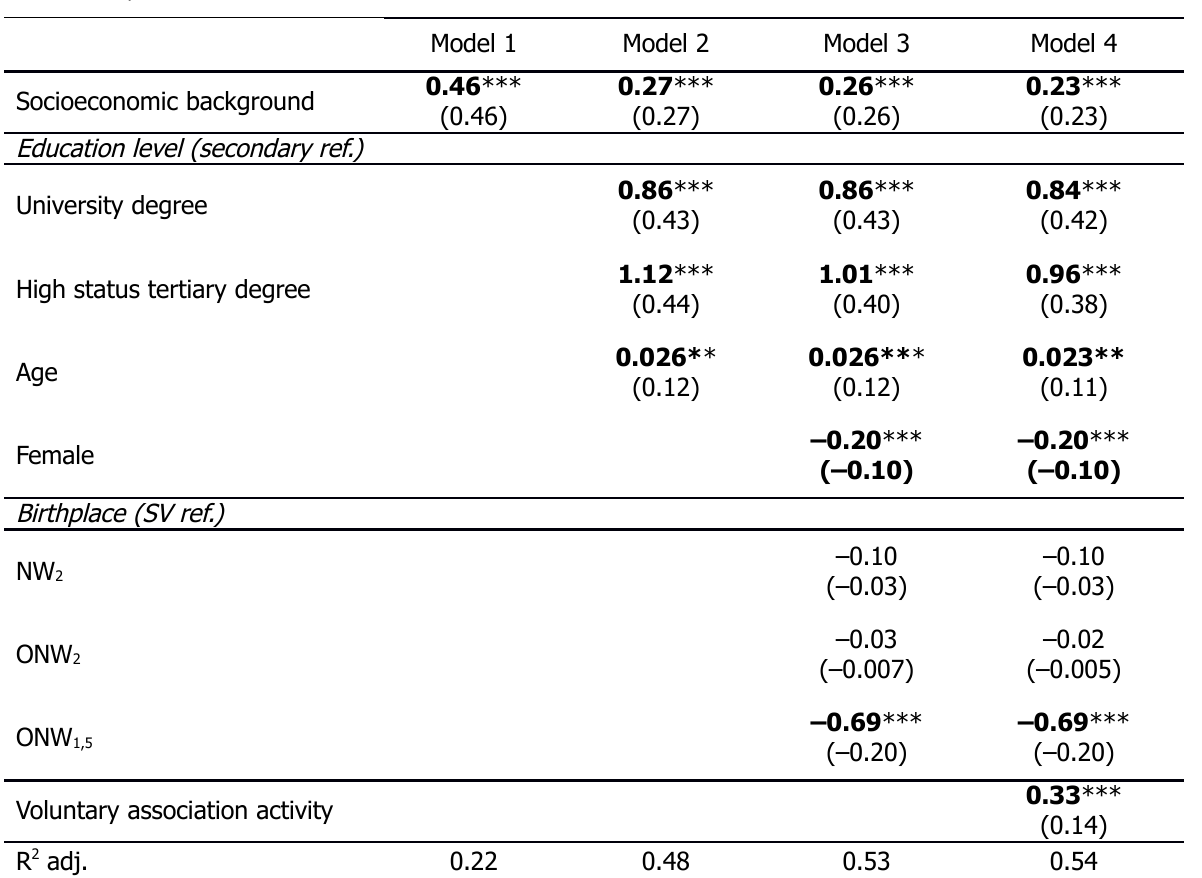
Table 3. Access to objectified state of social capital, OLS regression, partial (and standardized) coefficients, N =